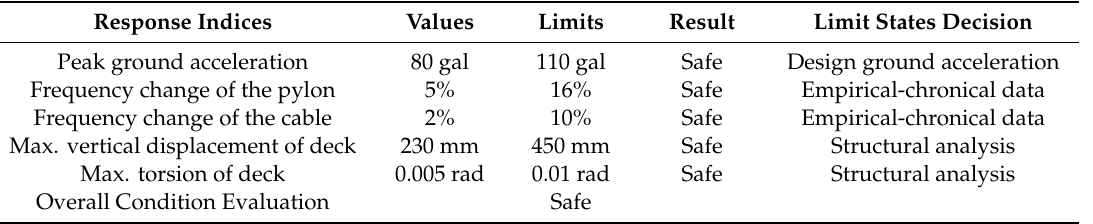
Table 1. Response indices and limit